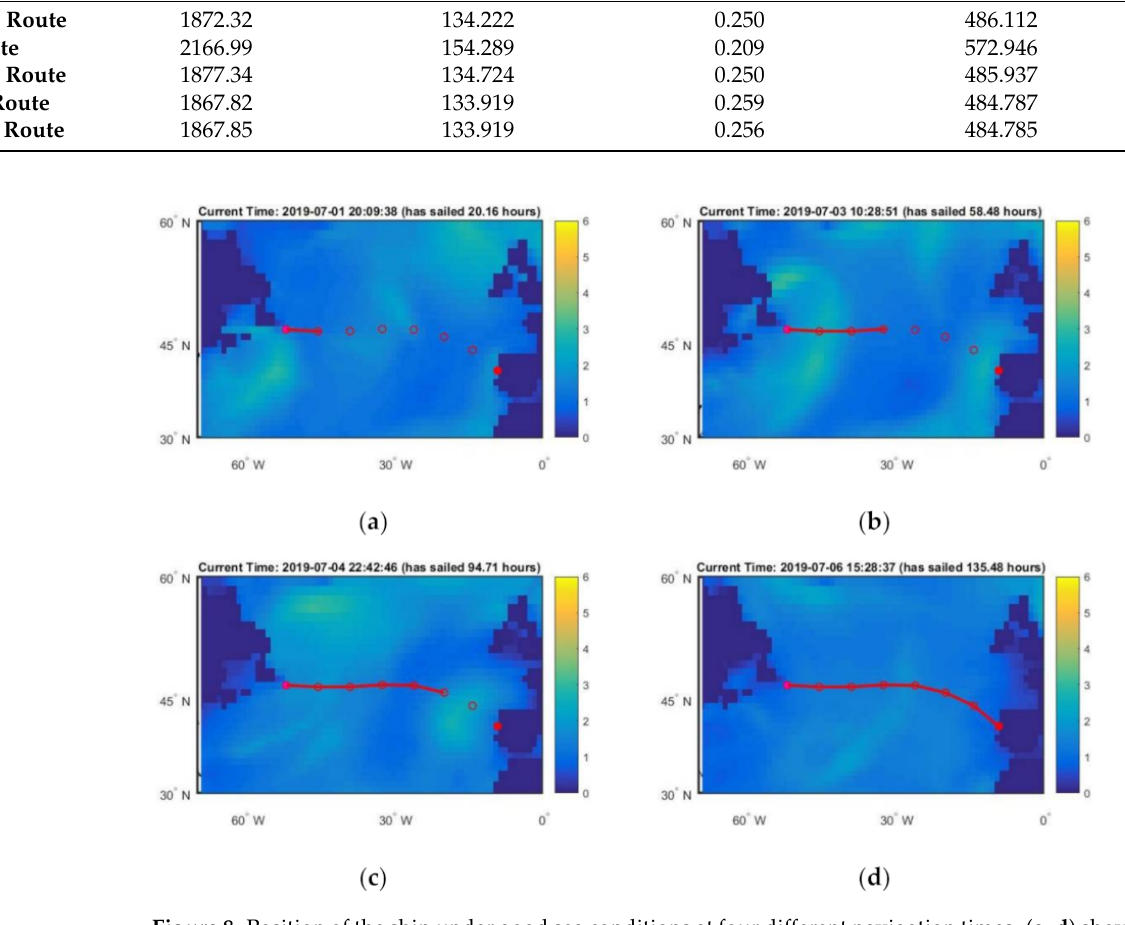
Figure 8. Position of the ship under good sea conditions at four different navigation times. ( a – d ) show the positions of the ship with respect to the wave height map at different